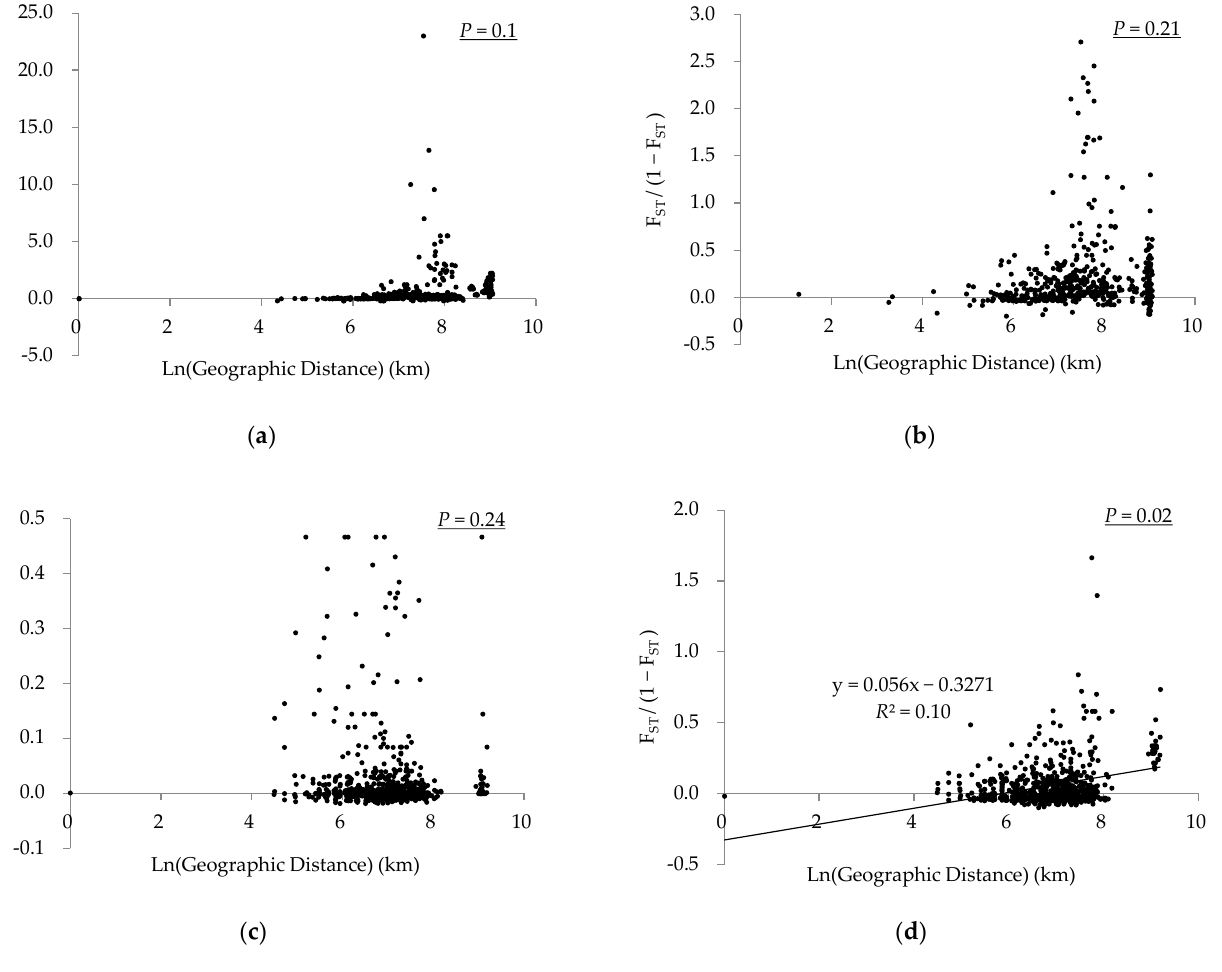
Figure 3. Genetic isolation by geographic distance (km) among different populations of two Rhopalosiphum aphids. ( a ): Combined COI and COII genes of R. padi ; ( b ): EF−1α gene of R. padi ; ( c ): combined COI and COII genes of R. maidis ; ( d ): EF−1α gene of R. maidis . Significance of the correlation between regression data was estimated from a Mantel test.